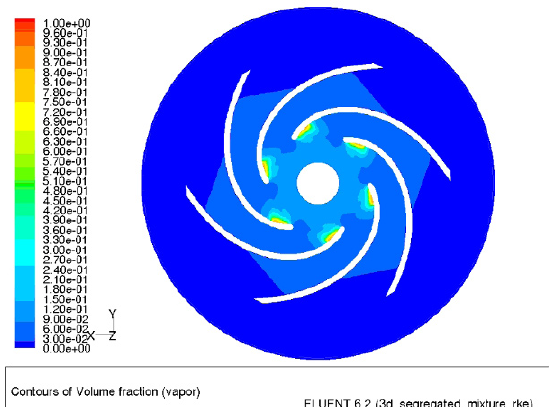
Figure 7. Result of numerical calculation - fraction of vapour versus NPSH - for impeller E3, Q = 2 m 3 /h .